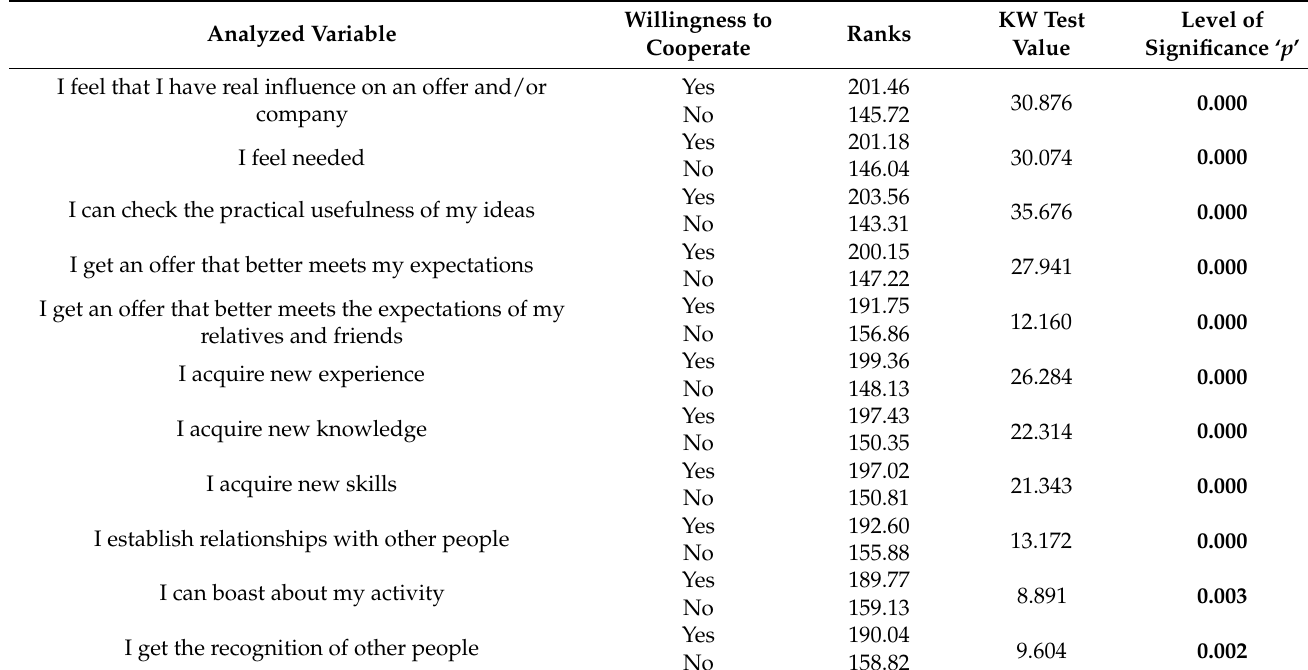
Table 7. Analysis of significance of differences between respondents’ opinions relating to the needs satisfied due to cooperation with offerors, according to the criterion of respondents’ willingness to undertake such cooperation. Analyzed Variable